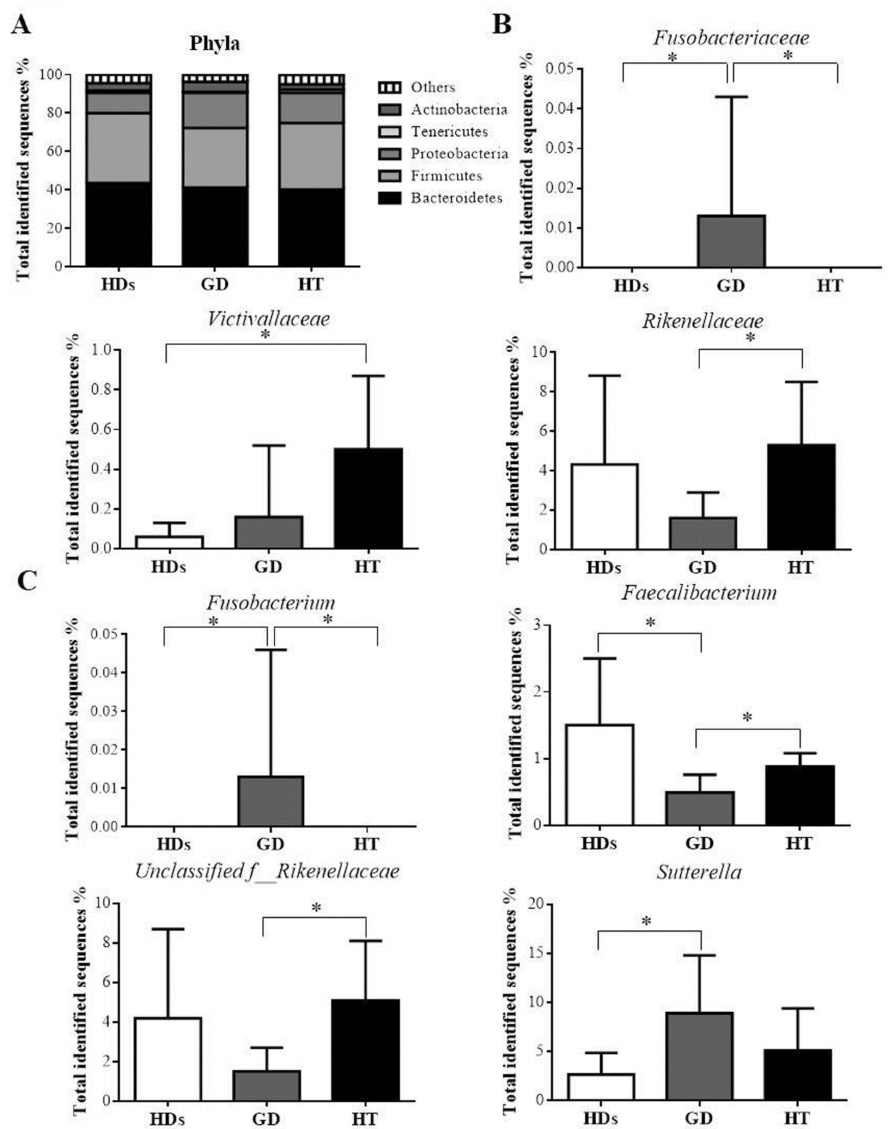
Figure2. ( A )Microbiotaprofileoffaecalsamples from thestudygroupsatthephylum level. ( B )Families statistically significant between the study groups. ( C ) Genera statistically significant between the study groups. * Indicates significant di ff erences between groups, q < 0.1 (q = p